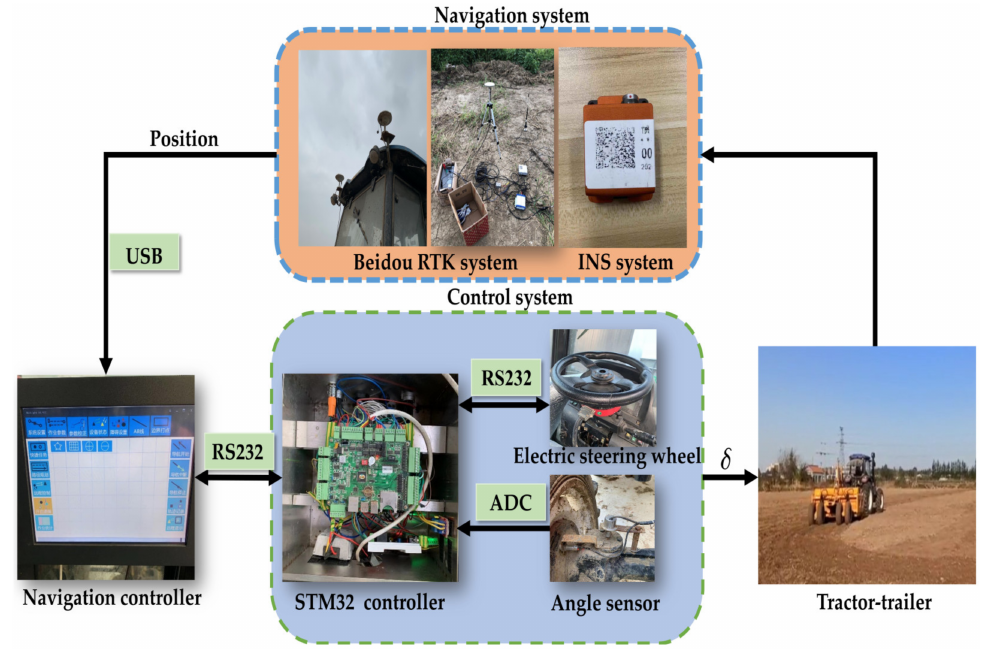
Figure 6. The experimental